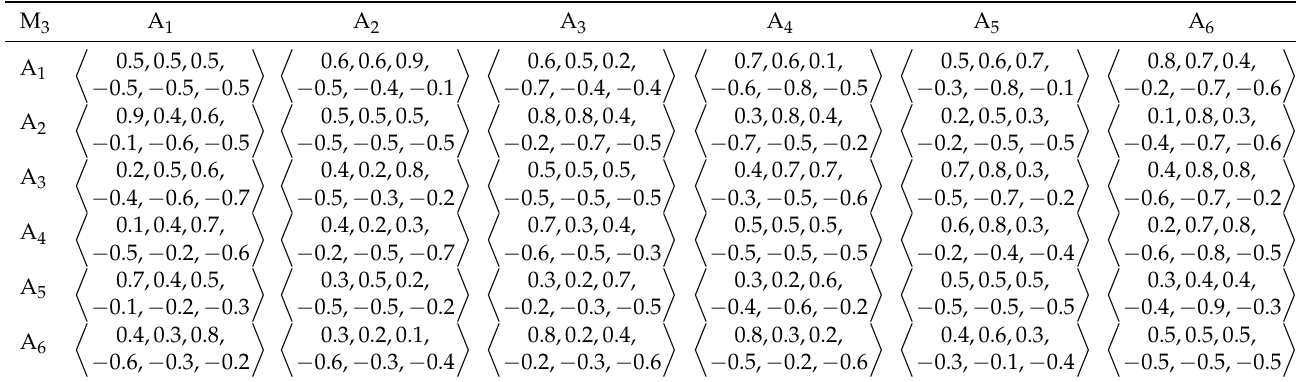
Table 10. BSVNPR of the expert from the human resource